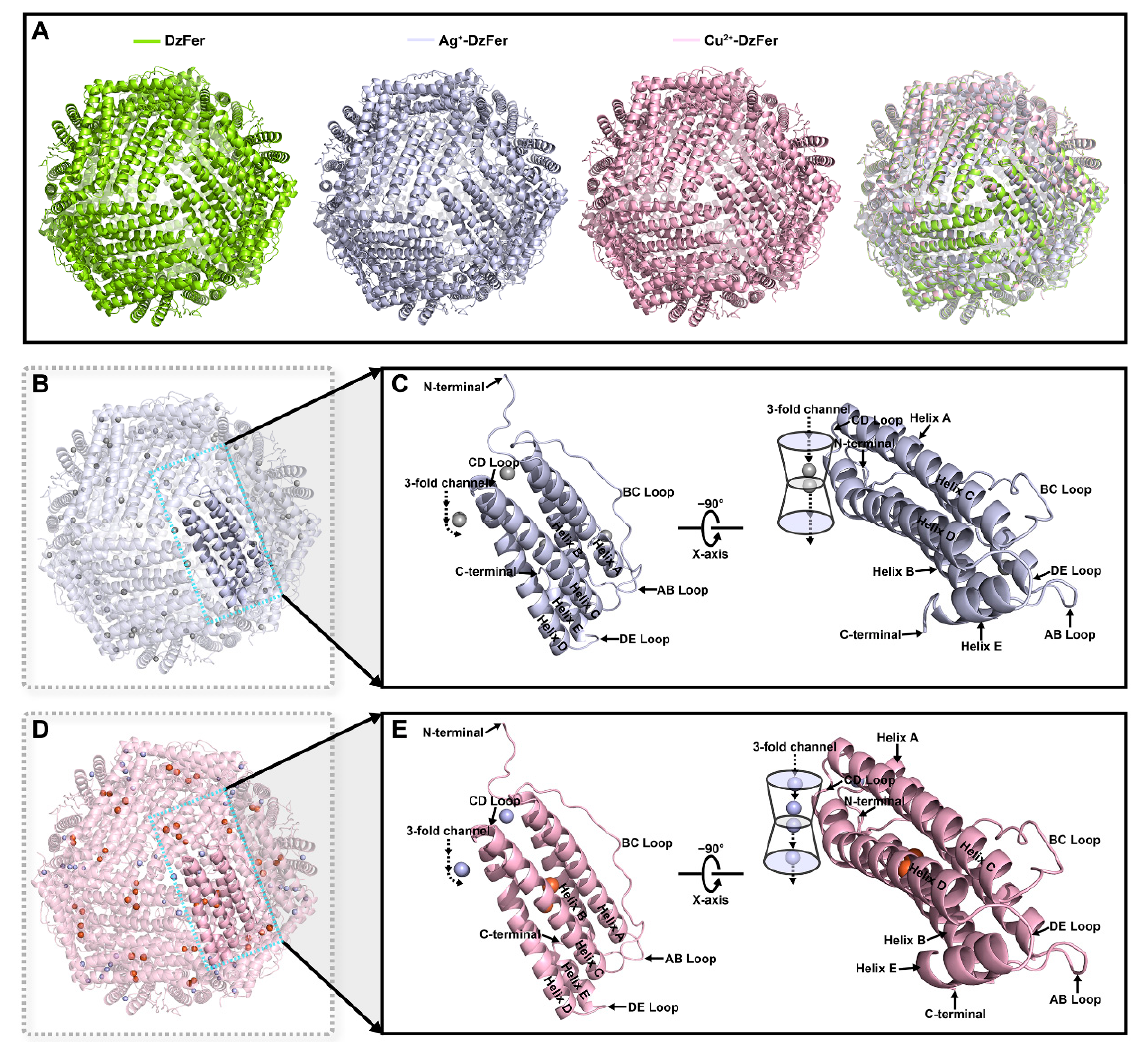
Figure 5. Cartoon representations of DzFer, Ag + -DzFer, and Cu 2+ -DzFer along the three-fold sym- metry axes based on the X-ray crystallographic analysis. ( A ) Superimposed structures of DzFer (light-green cage; PDB ID, 7EMK), Ag + -DzFer (blue-white cage), and Cu 2+ -DzFer (light-pink cage) in cartoon representation. ( B ) Overall architecture of Ag + -DzFer. ( C ) One subunit, stemmed from 24-mer cage-like structure of Ag + -DzFer, is shown as a detailed secondary structure cartoon and colored blue-white. ( D ) Overall structure of Cu 2+ -DzFer. ( E ) One subunit, stemmed from 24-mer cage-like structure of Cu 2+ -DzFer, is presented as a detailed secondary structure cartoon and colored light pink. Transparent cartoon view with α -helices shown as cartoons and bound metal ions as spheres. Bound metal ions are shown as orange spheres for Fe 3+ ions, silver-grey spheres for Ag + ions, and light-blue spheres for Cu 2+